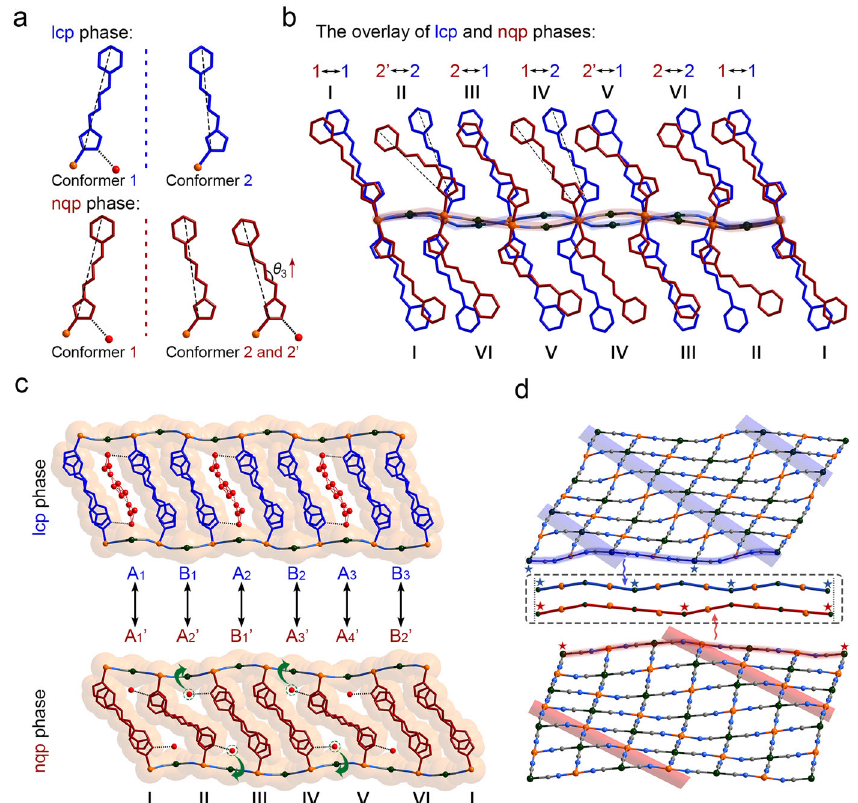
Fig. 5 Detailed structural transformation upon water adsorption. a Conformations of fl exible prentrz ligands in the lcp ( 1 ·9/2H 2 O) and nqp ( 1 ·4/3H 2 O) phases. b Local pedal rotations of prentrz molecules and the directional shifts of axial Fe − N coordination bonds. The ligands III, IV, and V perform in-plane pedal rotations around their N − N single bonds, and ligands II, III, IV, and V undergo distinct directional shifts with angles of 12.9°, 22.1°, 37.8°, and 18.0°, respectively. The pedal rotations and the reorientations of Fe − N bonds have opposite in fl uences on the principal directions of axial ligands. Consequently, ligands II and IV show the most signi fi cant shifts in their molecular orientations (as dashed lines indicated). c The directional shift of ligand II upon adsorption expands channel A 1 ’ and closes channel A 2 ’ , while the directional shift of ligand IV opens channel B 1 ’ and closes channel A 3 ’ . Accordingly, the four water molecules accommodated in pore A 2 ’ and A 3 ’ of nqp phase must be evacuated to facilitate the nqp – to – lcp lattice transformation. d The coordination layer demonstrated a remarkable crumpling/unfolding motion to assist the reorientation of the Fe − N coordination bonds. The structures of